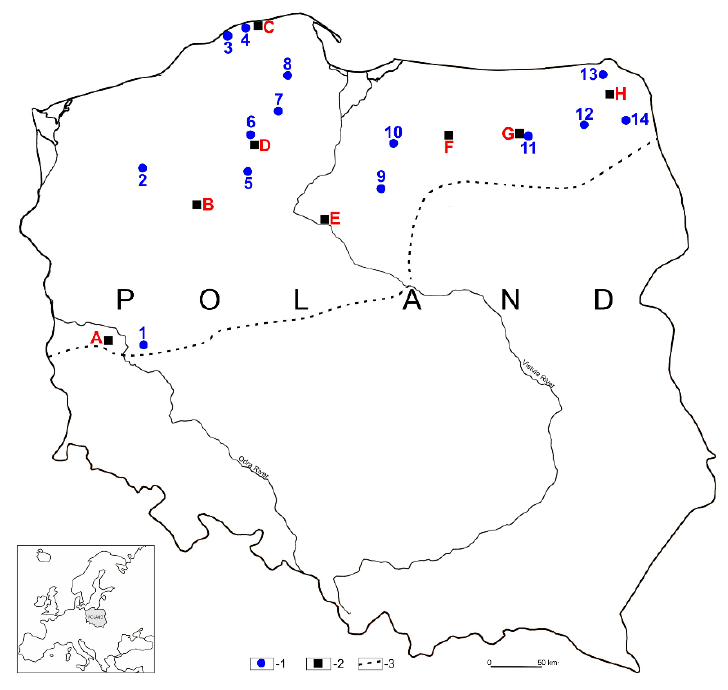
Figure 1. Location of study objects. 1—lakes, 2—meteorological station, 3—range of the Scandinavian glaciation.